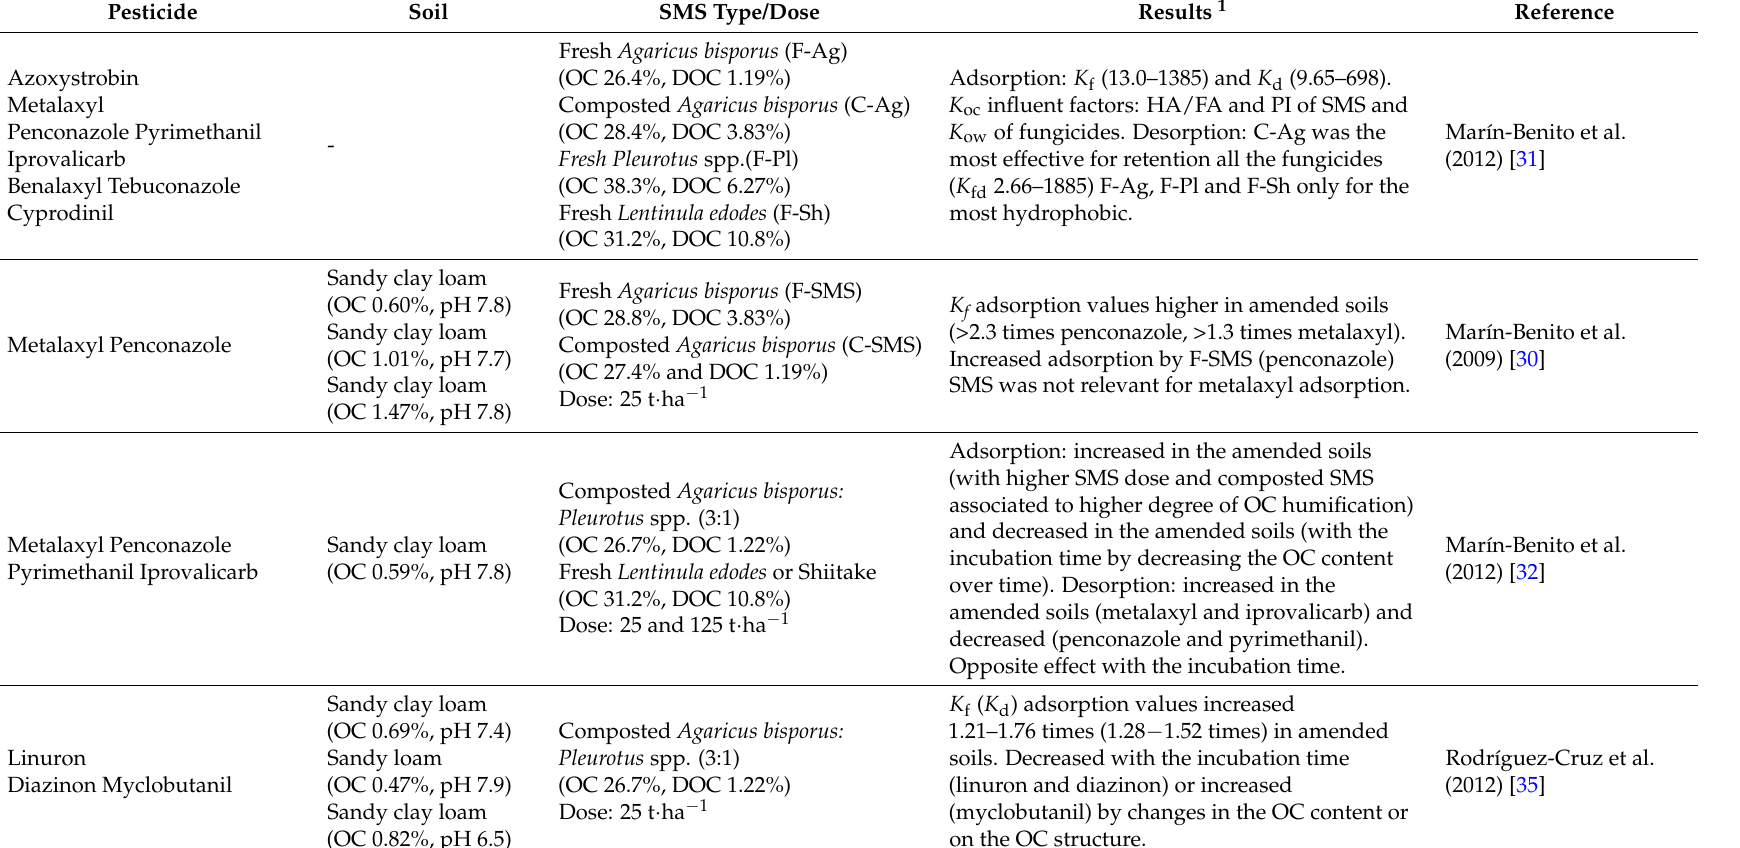
Table 3. Influence of SMS on the adsorption-desorption of pesticides by